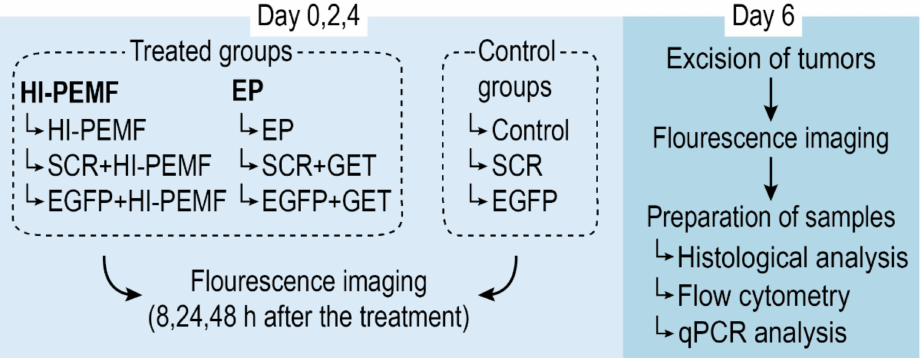
Figure 2. Overview of the treatment protocol for assessment of siRNA gene silencing in subcutaneous tumors. On day 0, mice were randomly divided into treated and control groups. Treated groups were subject to either HI-PEMF or GET (conventional electroporation (EP)) and intratumoral injections of either EGFP siRNA, siMAX universal bu ff er or SCR siRNA, whereas control groups were subject to injections only. Treatment and injections were performed every second day three consecutive times (on day 0, 2, and 4) followed by fluorescence imaging of the tumors 8, 24, and 48 h after the treatment. On day 6, tumors were excised, imaged, and prepared for histological, flow cytometry, and qPCR